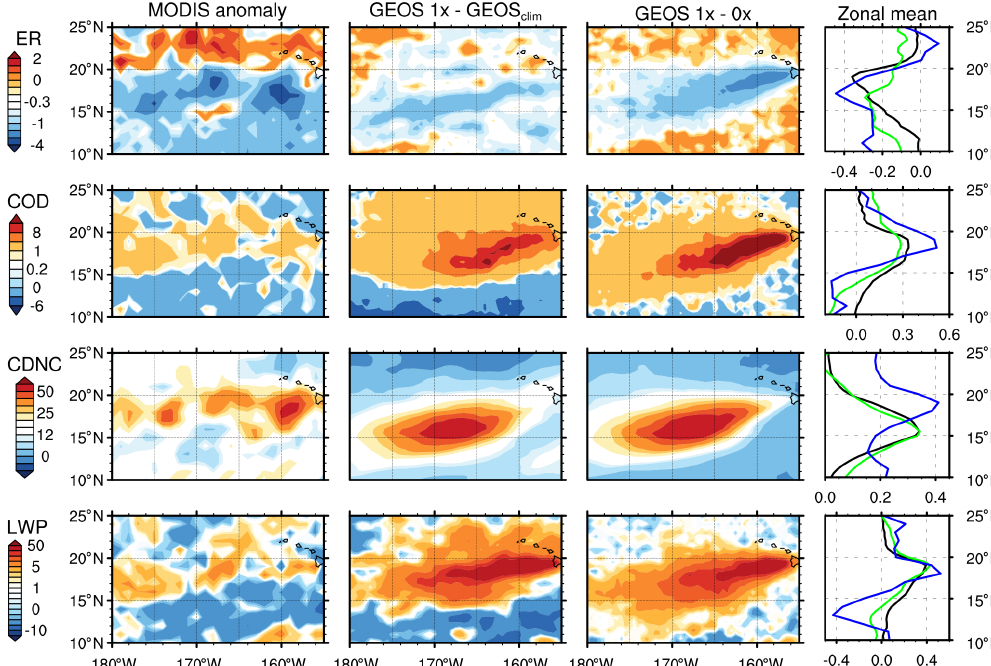
Figure 6. Anomaly in liquid cloud properties during JJA 2008 for (from top) R eff (µm, shown as ER), COD, CDNC (m − 3 ), and LWP (gm − 2 ). Anomalies are shown (from left) for MODIS observations and for GEOS simulations calculated against GEOS CLIM and the zero-emissions scenario. The rightmost column shows normalized zonal mean anomalies for MODIS (blue) and GEOS against GEOS CLIM (green) and zero emissions (black).